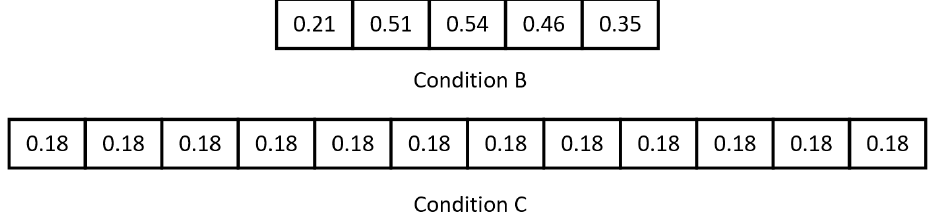
Figure 16. Condition B, C braking sequence.